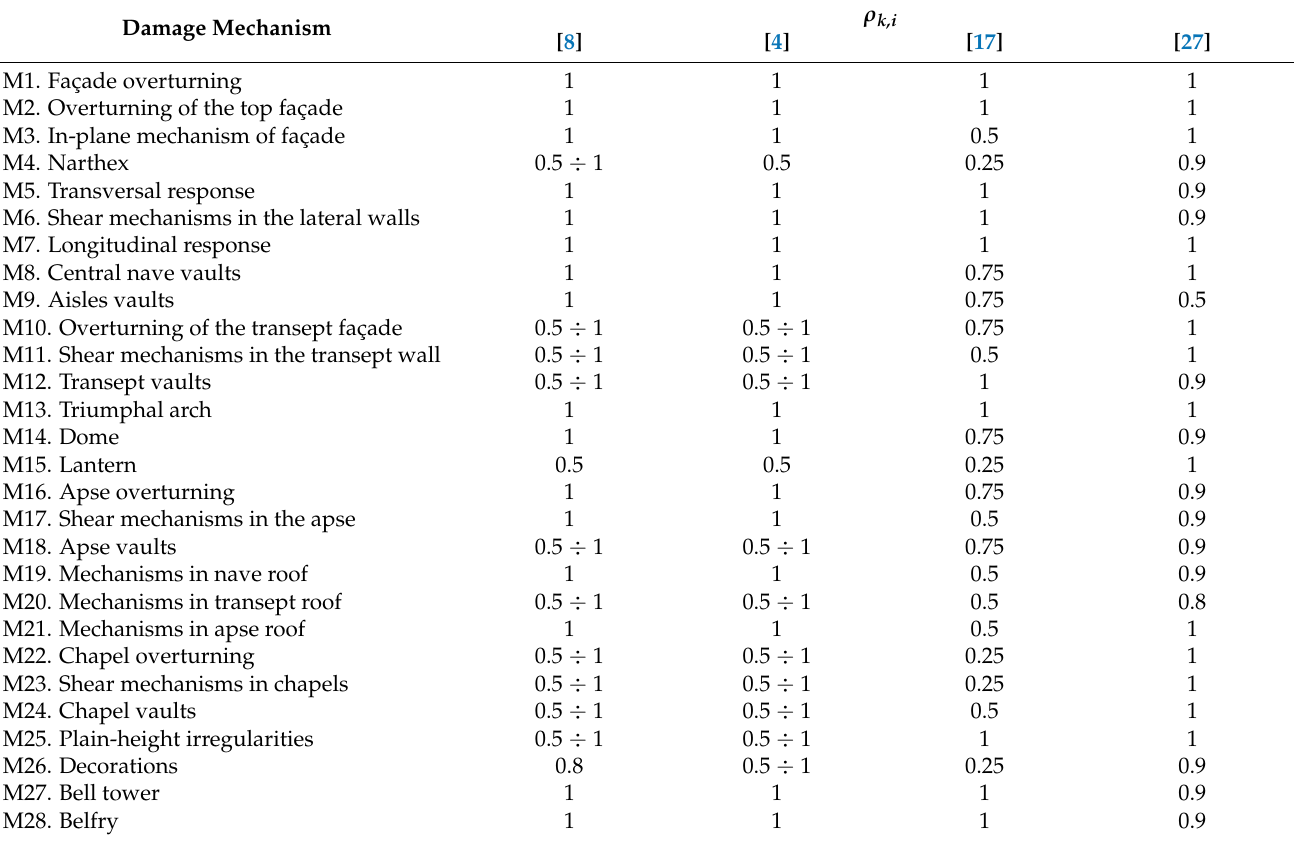
Table 4. Values for the importance score factor ρ k,i assumed in reference